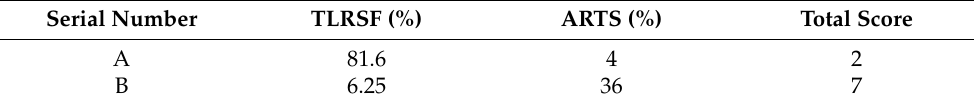
Figure 8. Results of strong constraint process (SCP) (The base map is sentinel-2 optical image): ( a ) subsidence filtering result (SFR); ( b ) subsidence filtering correction result (SFCR); ( c ) NFR; ( d ) NDVI filtering correction result (NFCR). Table 3. Comparison table for the evaluation of suspected coal fire risk level in the study area.